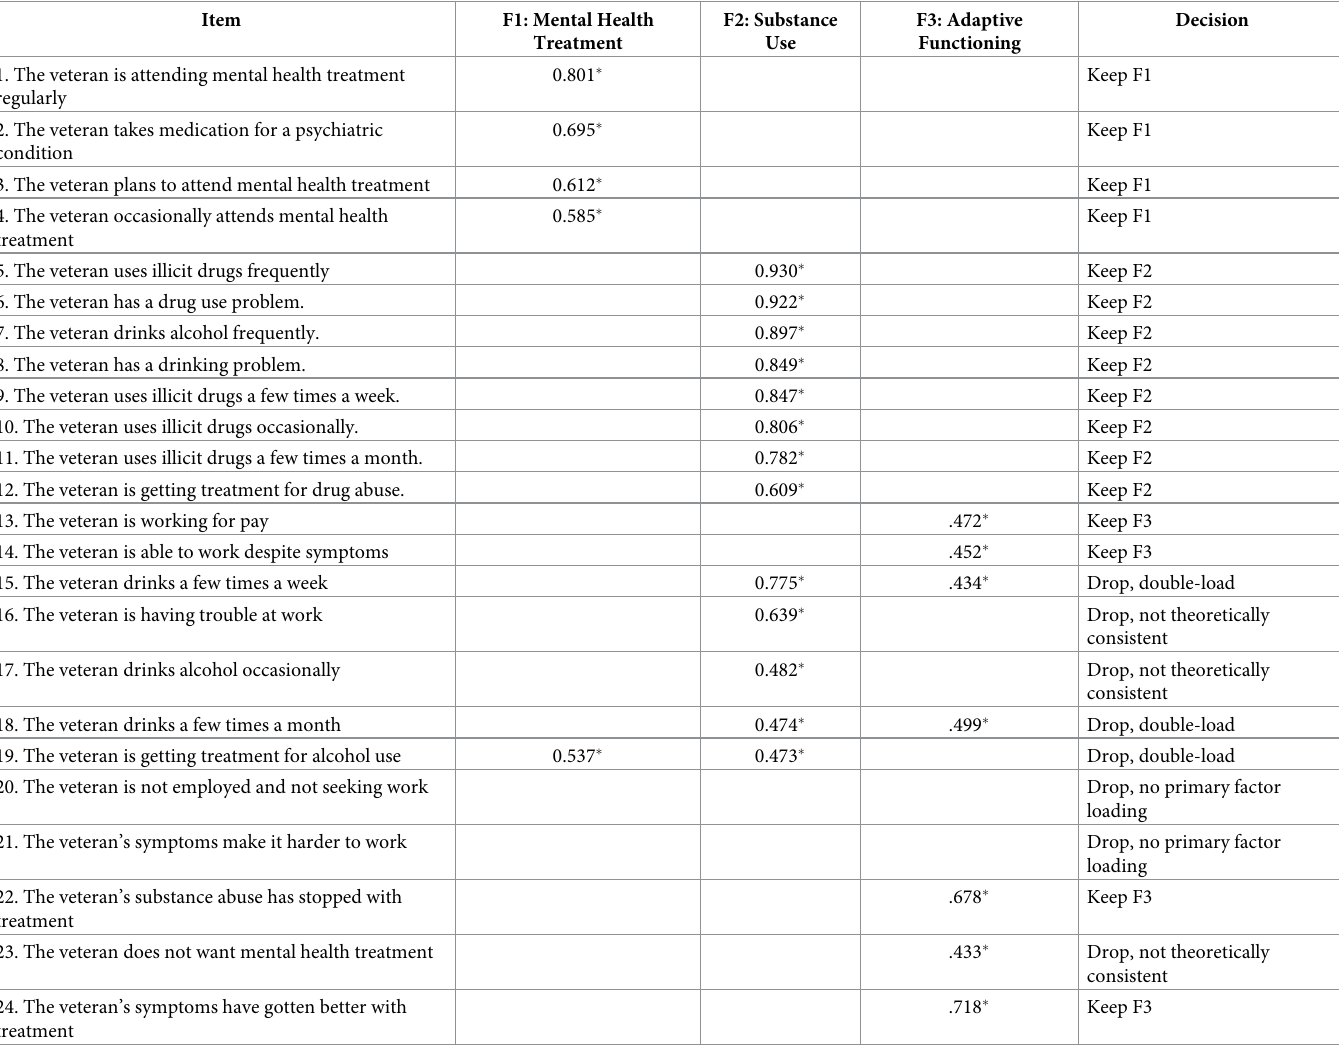
Table 2. Disability beliefs scale items and factor